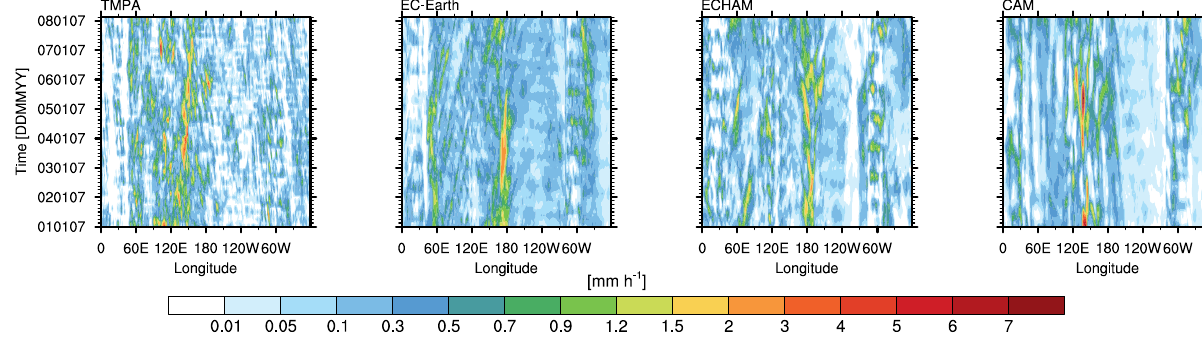
Figure 11. Time–longitude illustration of all rain rates across the tropics within ± 5 ◦